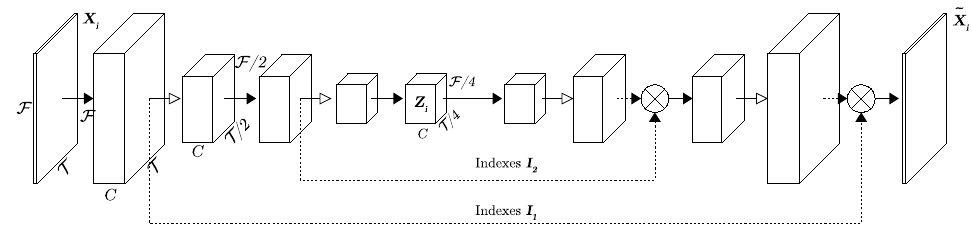
Figure 2. Diagram of the proposed autoencoder. Filled arrows represent convolutional (both normal and transpose) layers. The unfilled arrows point out max-pooling (in the encoder) or upsampling (in the decoder) layers. Dashed line arrows illustrate